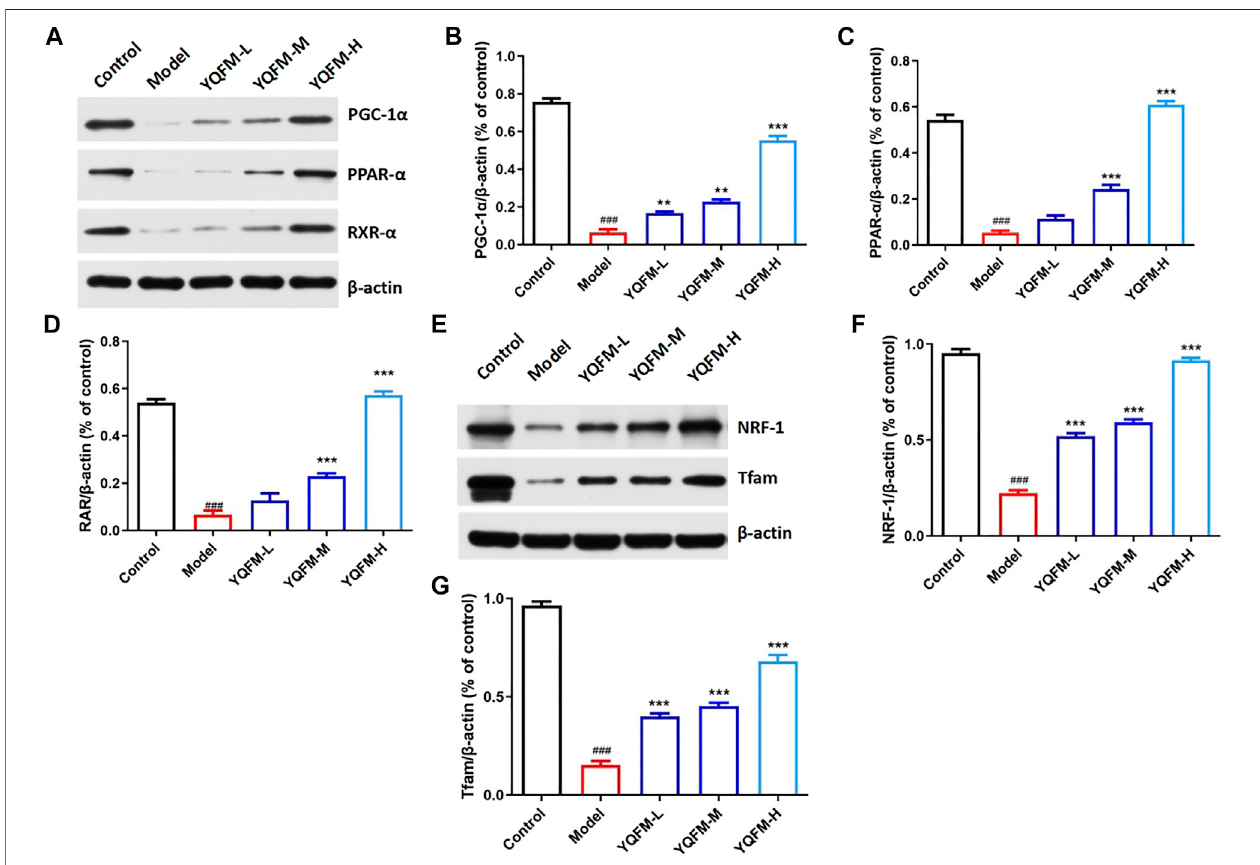
FIGURE11| YQFMupregulated mitochondrial biogenesis-relatedgeneswithPGC-1 α activation. (A) Theamount ofPGC-1 α ,PPAR- α and RXR- α fromH9C2 cells lysate wasexamined by Westernblot analysis. (B – D) Relative protein levels were measured by densitometry for PGC-1 α ,PPAR- α and RXR- α . (E) The amount of NRF-1 and Tfam from H9C2 cells lysate was examined by Western blot analysis. (F,G) Relative protein levels were measured by densitometry for NRF-1 and Tfam ( n (cid:2) 3 per group). Data are means ± SD. * p < 0.05, ** p < 0.01, *** p < 0.001 vs the Model group, # p < 0.05, ## p < 0.01, ### p < 0.001 vs the Control